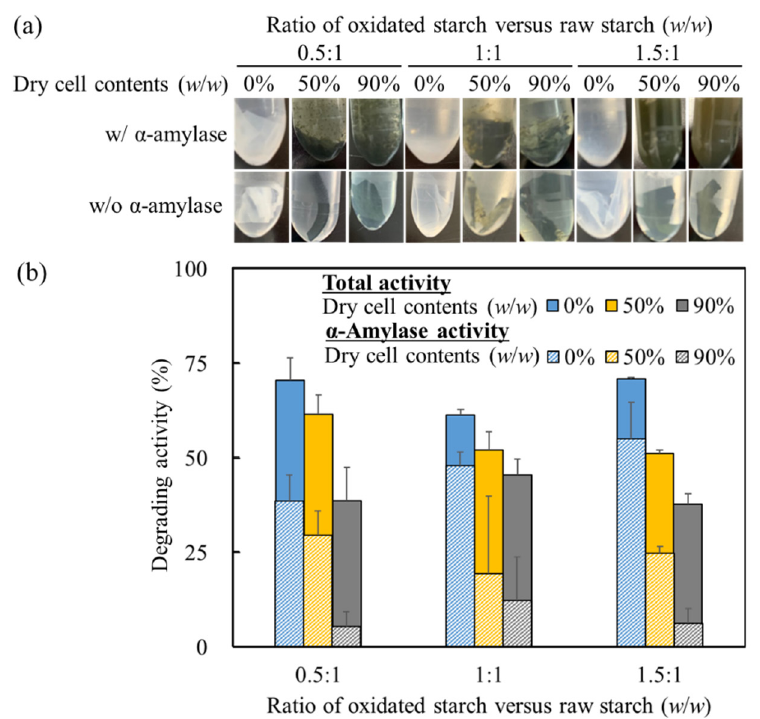
Figure 6. Evaluation of biodegradation of starch cell-plastics with amylase, displaying ( a ) visualized images of starch cell-plastics and starch after 24 h treatment, and ( b ) degrading activities for starch cell-plastics. Values are the averages of three replicated experiments, ±SD.